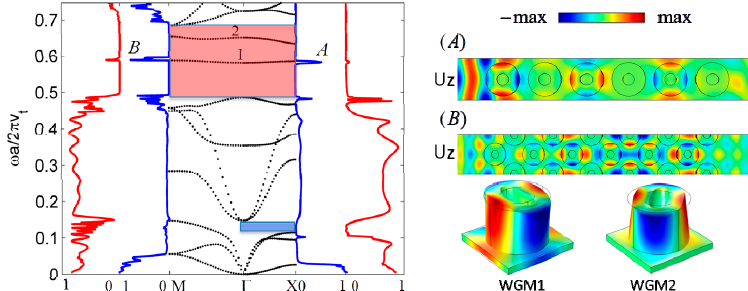
Figure 2. ( Left panel ): Dispersion curves of the confined hollow pillars on a thin silicon plate in the Γ X and Γ M directions of the first irreducible Brillouin zone in the reduced frequency range [0; 0.75]. On each side of the dispersion curves, we give the corresponding transmission spectra in blue and red respectively for which the incident wave is either anti-symmetric A 0 or symmetric S 0 . The Bragg and low frequency band gaps are marked as red and blue rectangular hatched regions, respectively. The geometric parameters are chosen as r i /a = 0.145, r/a = 0.4, h/a = 0.45, e/a = 0.1, l/a = 0.2; ( Right panel ): Uz component of the displacement fields with the anti-symmetric A 0 Lamb wave excitation at transmission peak A along the Γ X direction and peak B along the Γ M direction; Uz component of the displacement fields of WGM1 and WGM2 at Γ point.